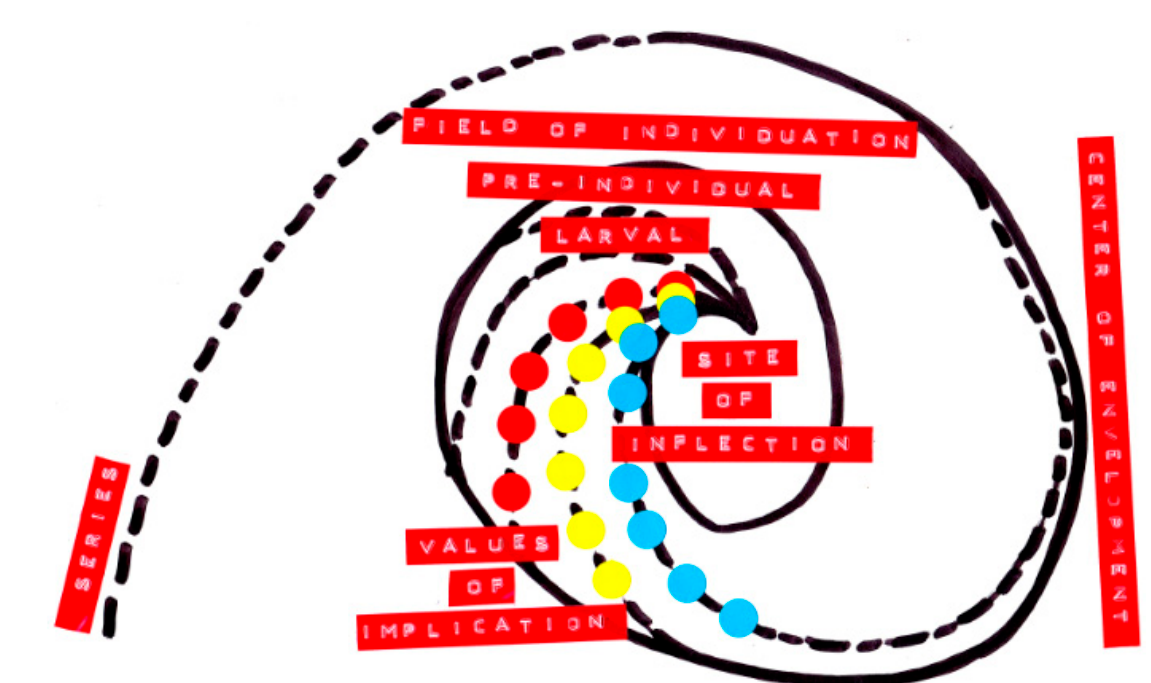
Figure 2. Center of envelopment, site of inflection, Point of View (POV).